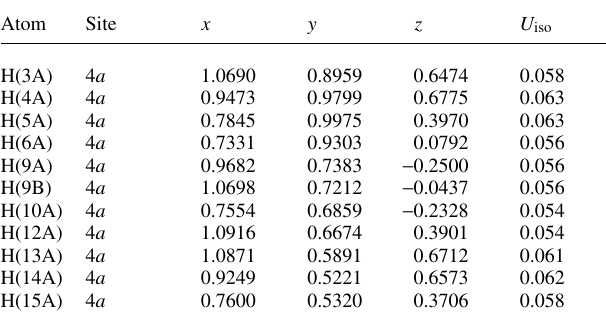
Table 2. Atomic coordinates and displacement parameters (in Å 2 )